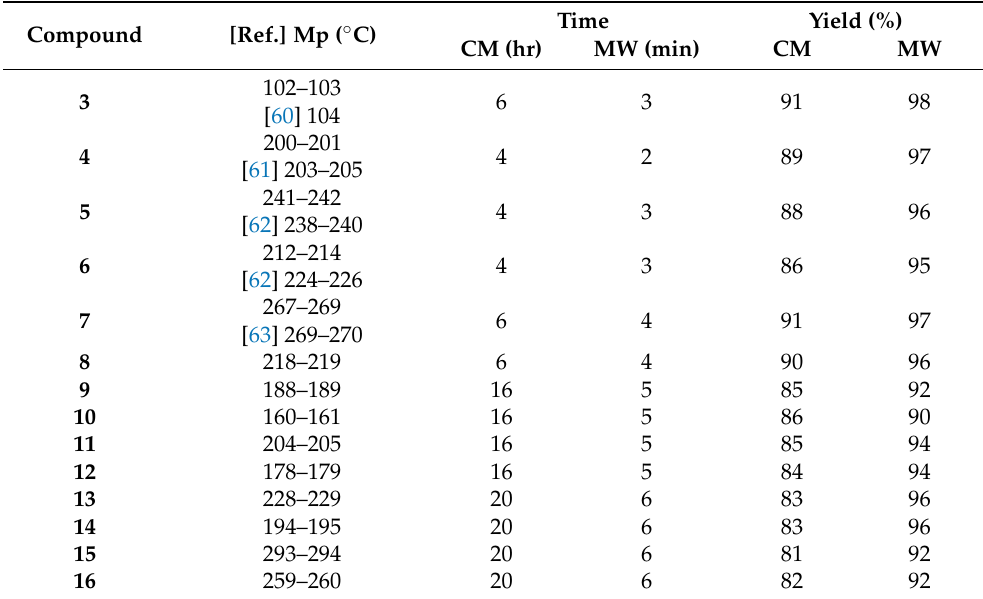
Table 1. Comparison between the conventional method (CM) and microwave irradiation (MW) in the synthesis of compounds 3 – 16